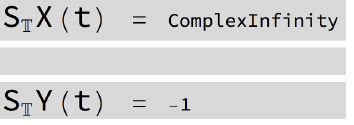
Figure 20. Output given by the [SInt] algorithm.